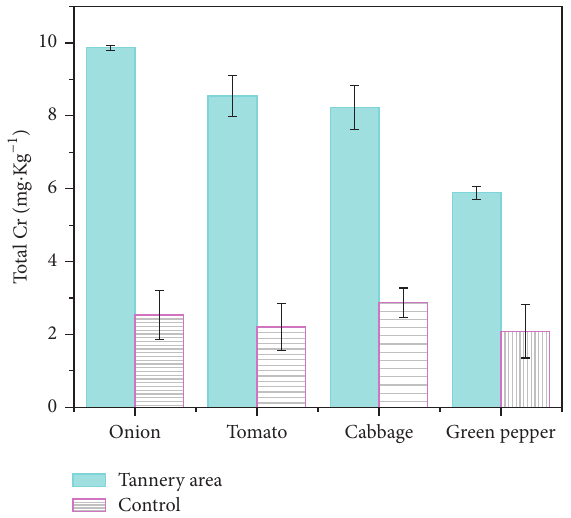
Figure 4: Mean values and standard deviations of total Cr con- centrations recorded in tannery effluent irrigated vegetable samples cultivated around (1km radius) tannery